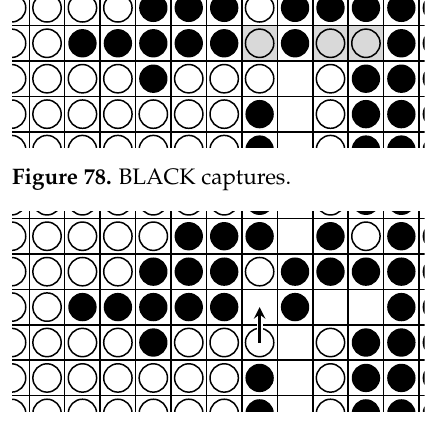
Figure 79. WHITE intrudes.